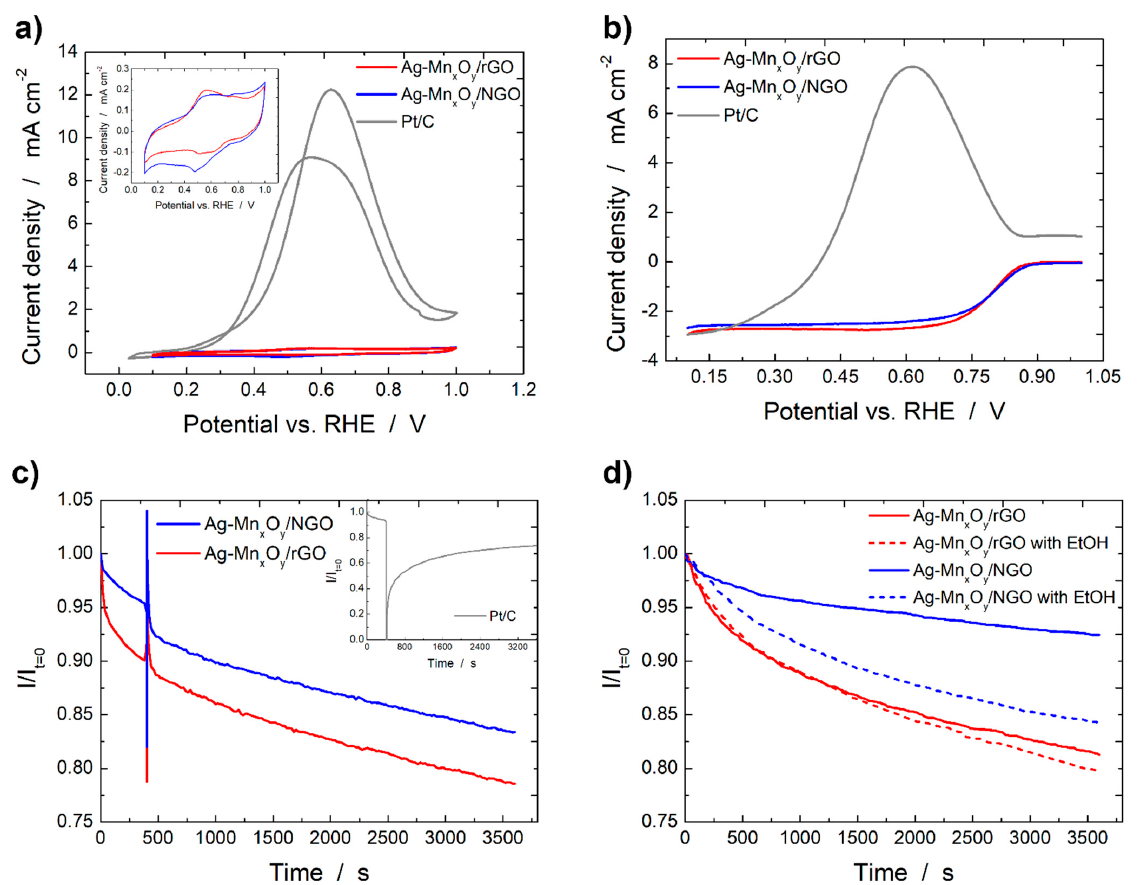
Figure 8. CVs ( a ), ORR curves ( b ), and influence of EtOH addition during chronoamperometry ( c ) of Ag-Mn x O y /rGO, Ag-Mn x O y /NGO, and Pt/C, as well as stability test ( d ) of Ag-Mn x O y /rGO and Ag- Mn x O y